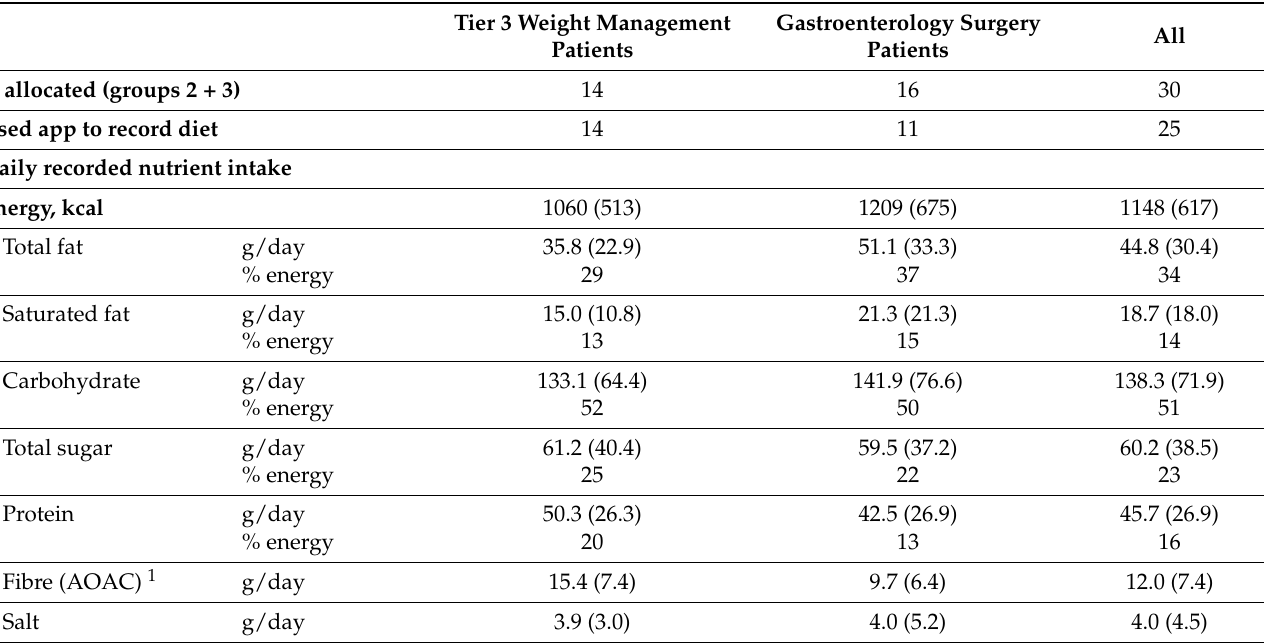
Table 3. Nutrient intake recorded using the app among app users.